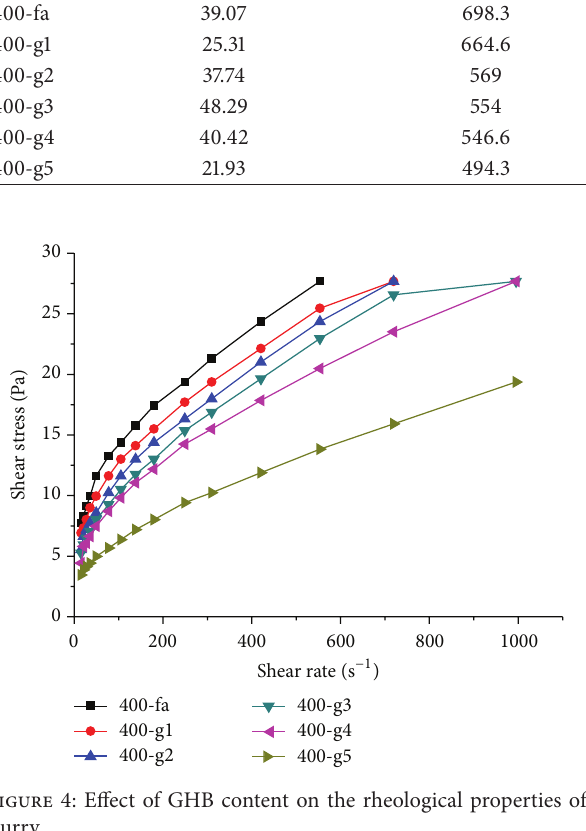
Figure 4: Effect of GHB content on the rheological properties of slurry.